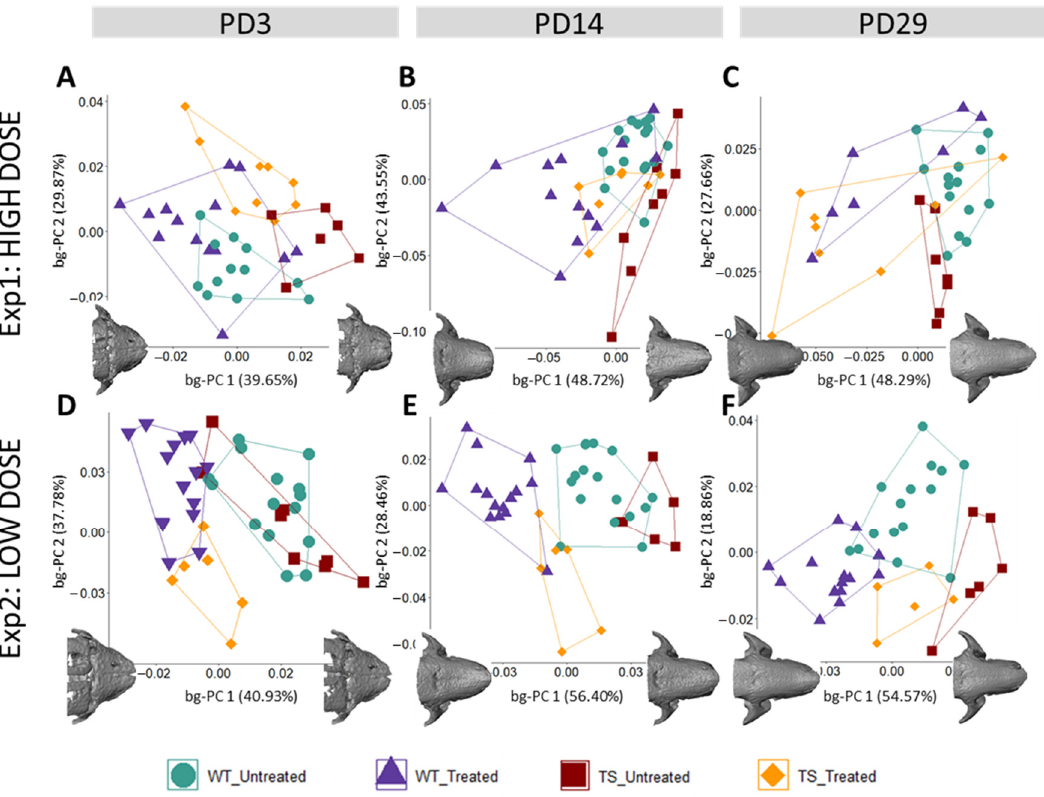
Figure 2. Postnatal face shape differences between wildtype and trisomic mice across development and the effects of high ‐ and low ‐ dose GTE ‐ EGCG treatment. Facial shape variation as shown by a between ‐ group principal component analysis (bg ‐ PCA) based on the 3D coordinates of a subset of landmarks placed on the surfaces of 3D renders from in vivo μ CT scans (Supplementary Table S3) at ( A , D ) PD3, ( B , E ) PD14, and ( C , F ) PD29. Longitudinal data from experimental setting 1 are presented on the top row, whereas data from experimental setting 2 are presented on the bottom row. All scatter plots are presented along with the morphings associated with the negative and positive extremes of the bg ‐ PC1 axis. Notably, even though the groups of untreated mice used in